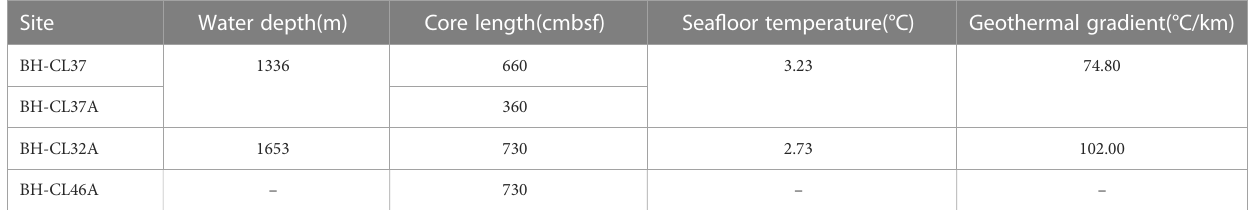
TABLE 1 Details of the study sites.